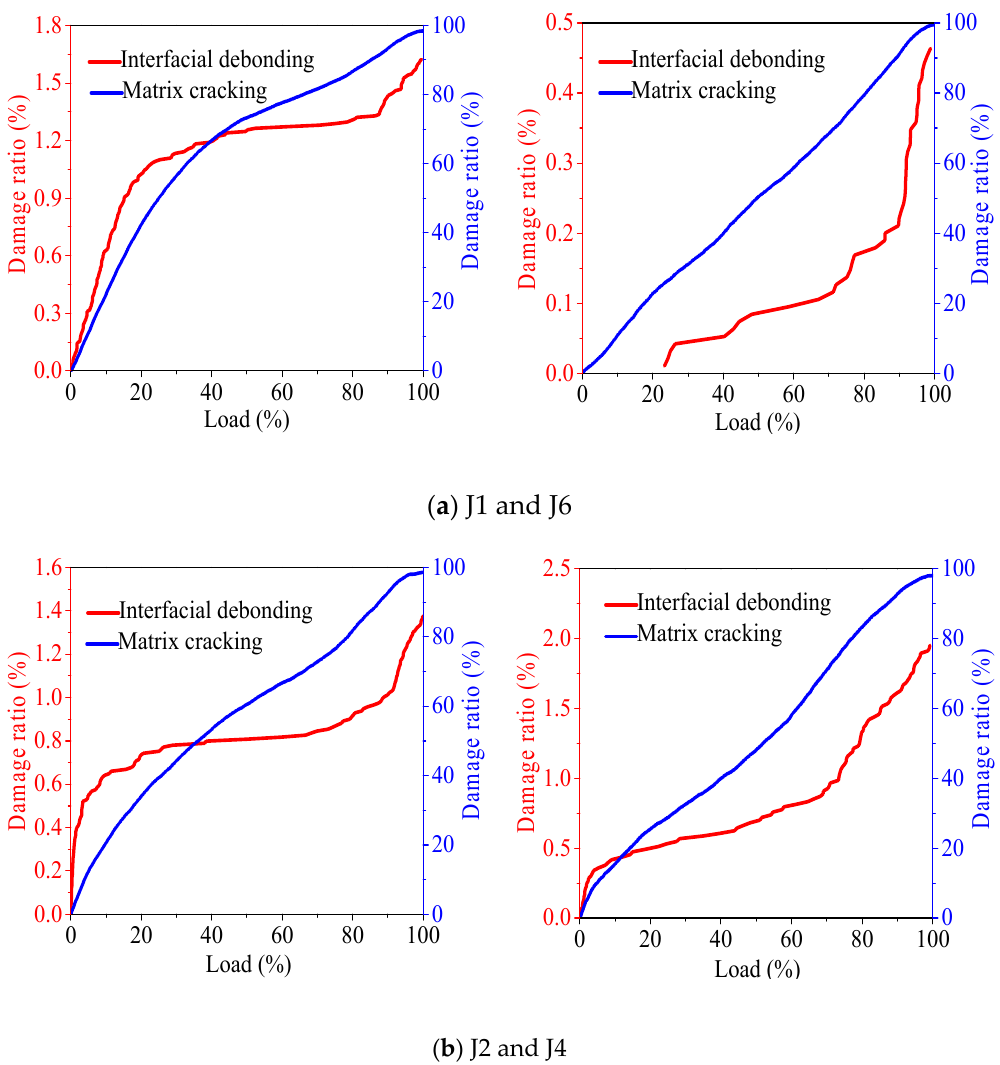
Figure 7. The influence of coarse aggregate on the failure state of concrete.